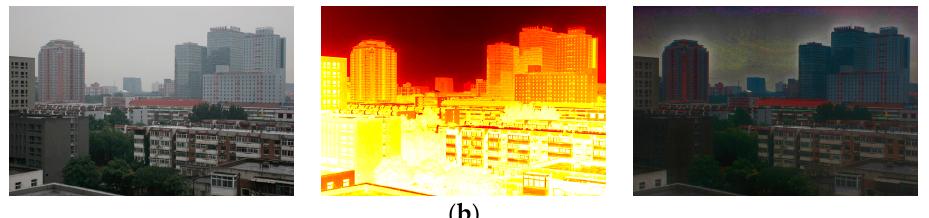
Figure 9. From left to right: two challenging haze images, the corresponding transmission maps fusion t and the relevant recovered images. ( a ) Hazy image with small sky region, the corresponding transmission map fusion t , and the relevant recovered image. ( b ) Hazy image with large sky region, the corresponding transmission map fusion t , and the relevant recovered image.